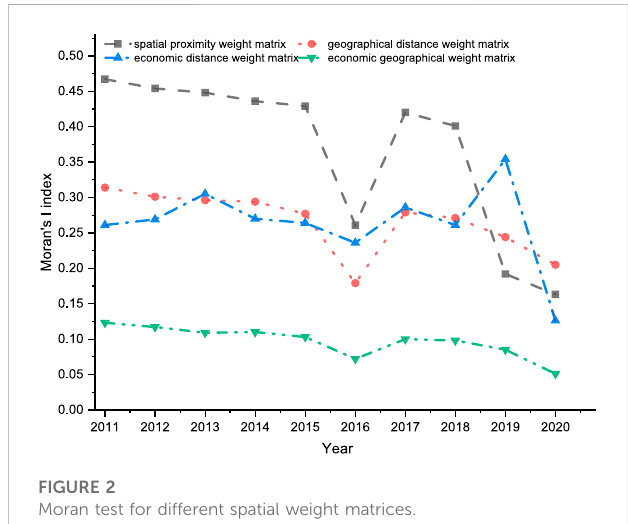
FIGURE 2 Moran test for different spatial weight